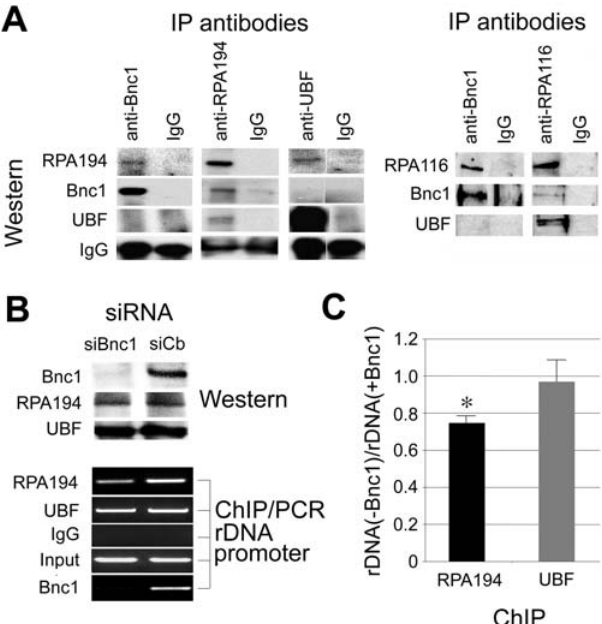
Figure 3. Basonuclin is associated with RPA194 and RPA116, subunits of Pol I. A , Immunoprecipitations detected a basonuclin-RPA194/ RPA116 complex. Immunoprecipitations (IP) were performed with extract of HaCaT cells cultured to a high density and analyzed by Western blots. The IP antibodies are indicated above the gel image and that used for Western blots on the left. B , Basonuclin-deficiency reduces the association of RPA194 and rDNA promoter. Basonuclin was knocked-down in HaCaT cells by siRNA and the cells were analyzed by Western for protein levels and by ChIP for association of various factors to rDNA promoter. The Western (upper panel) showed that basonuclin level was reduced to below detection by treatment of siBnc1-s, but the level of RPA194 and UBF was not affected. The lower panel shows the results of PCR analysis of the amount of rDNA promoter precipitated by ChIP. The siRNA reagents the same as indicated in the upper panel. The Western and ChIP antibodies are indicated on the left. C , A quantification of rDNA promoter precipitated by anti-RPA194 in the presence and absence of basonuclin. Shown are qPCR results normalized to the rDNA quantity in the presence of basonuclin. An asterisk indicates p , 0.05 (n=3).